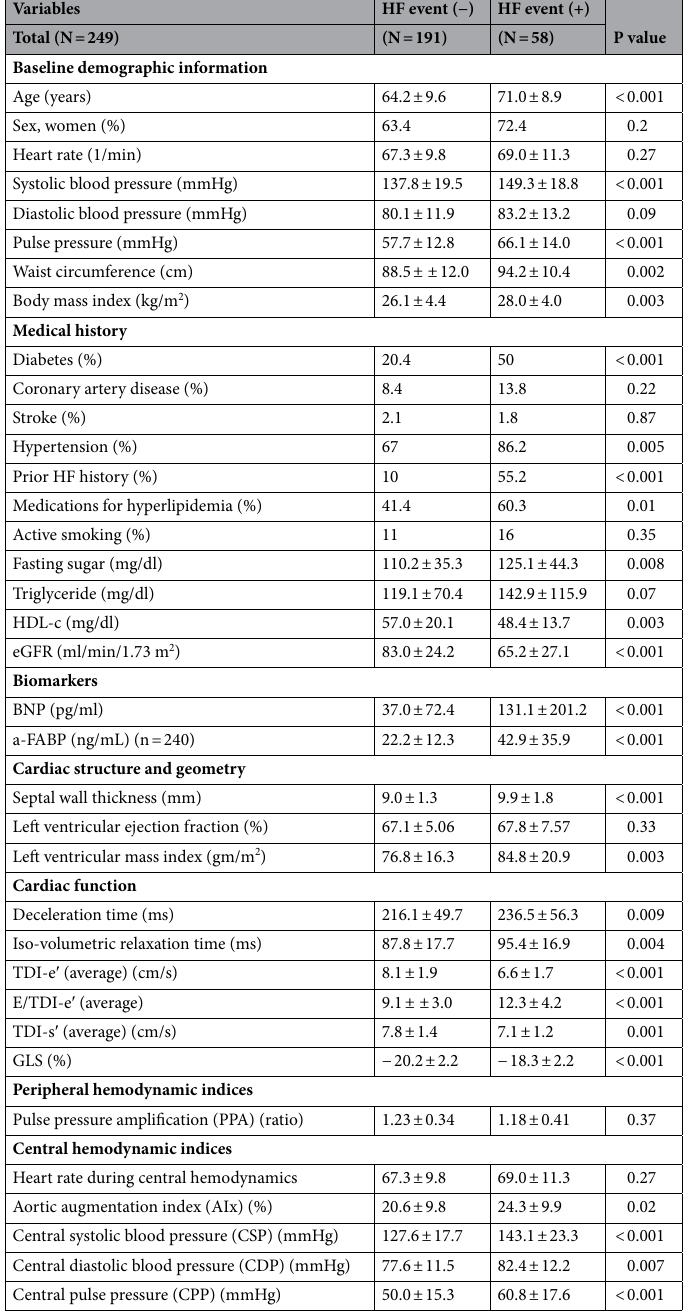
Table 1. Baseline patient characteristics. HF, heart failure; LDL-c, low-density lipoprotein-cholesterol; HDL- c, high-density lipoprotein-cholesterol; eGFR, estimated glomerular filtration rate; BNP, brain natriuretic peptide; a-FABP, adipocyte free fatty acid binding protein; LV, left ventricle; E/A ratio, E wave/late A wave of Doppler-based mitral inflow; TDI-e ′ , peak myocardial diastolic relaxation velocity on tissue-based Doppler; E/TDI-e ′ , E wave/TDI-e ′ ; TDI-s ′ , peak myocardial systolic relaxation velocity of tissue-based Doppler; GLS, global LV longitudinal systolic myocardial